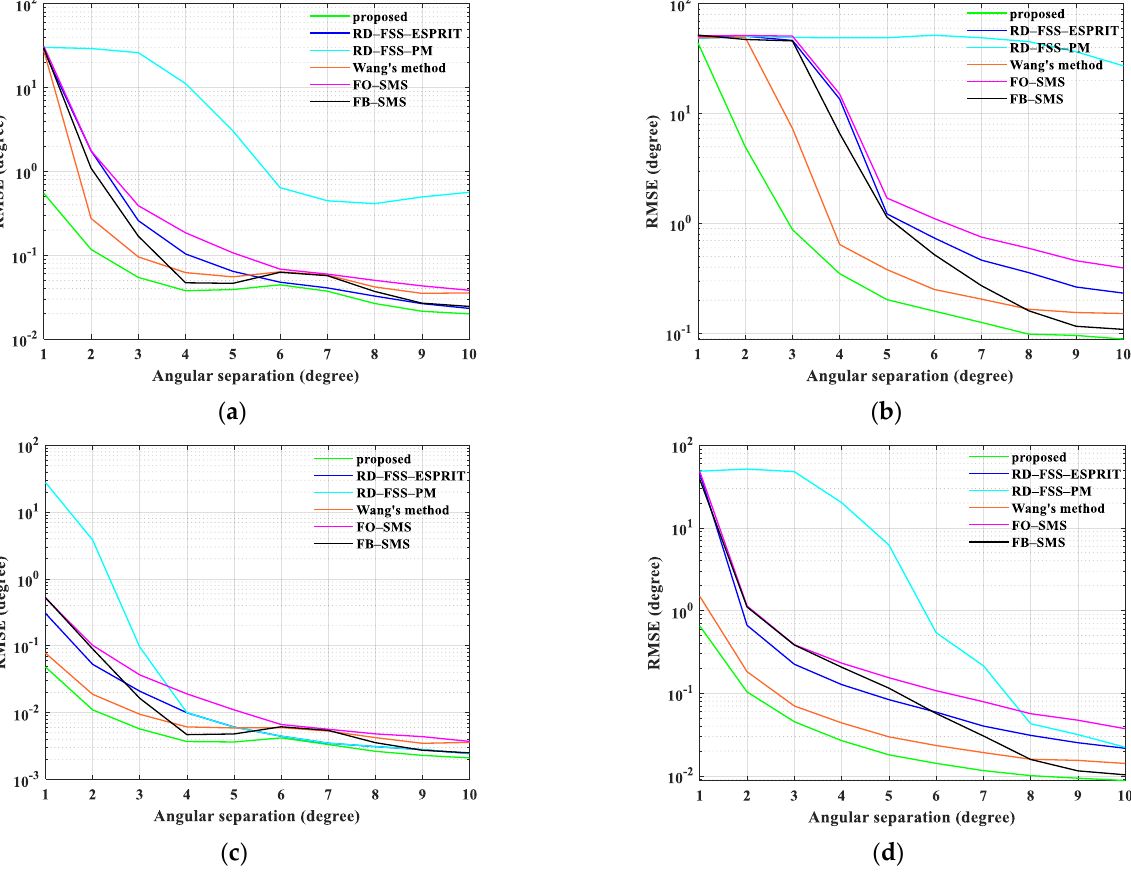
Figure 7. RMSE versus the angular separation. ( a ) Scenario 1: two coherent targets are located at